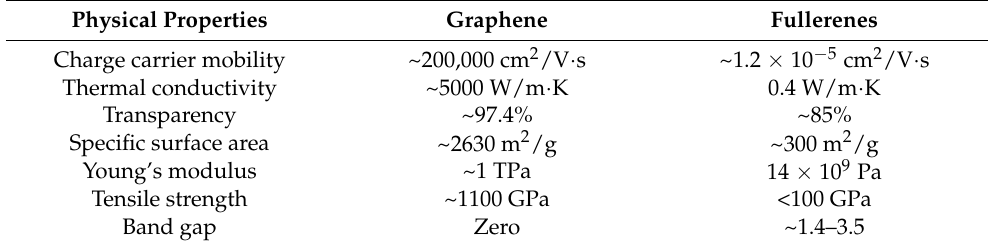
Table 3. Comparative listing of physical properties of Graphene and Fullerenes. Physical Properties Graphene Fullerenes Charge carrier